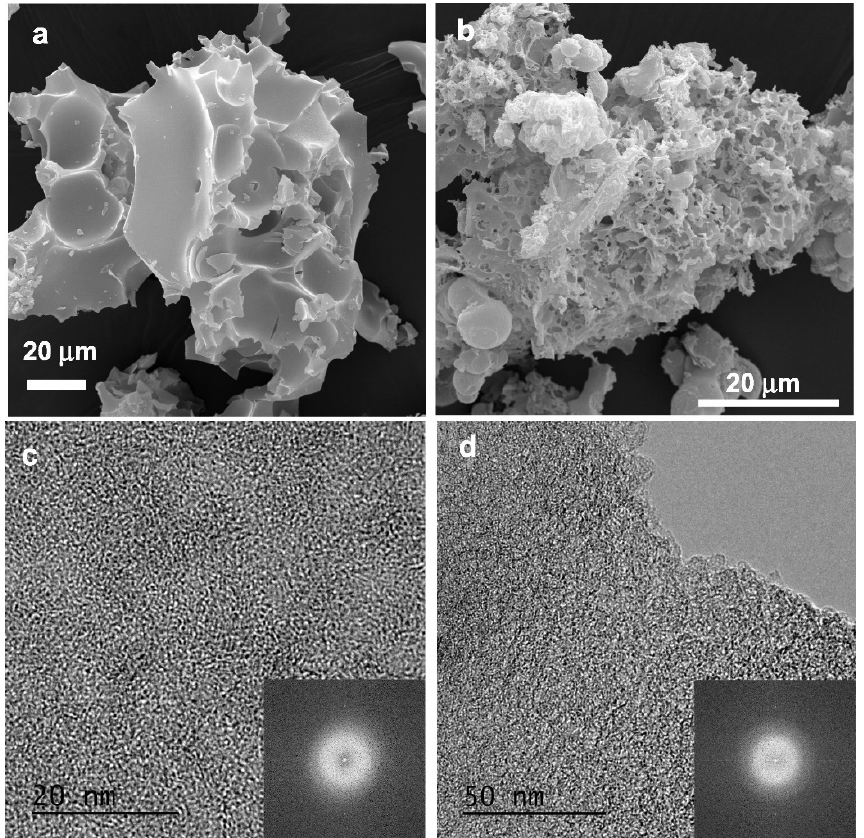
Figure 4. SEM images of a typical powdered renewable carbon ( a , b ) and transmission electron microscopy (TEM) images corresponding to its pore structure ( c , d ). Insets in ( c , d ) show the FFT pattern which confirms the amorphous structure of renewable carbon [17].